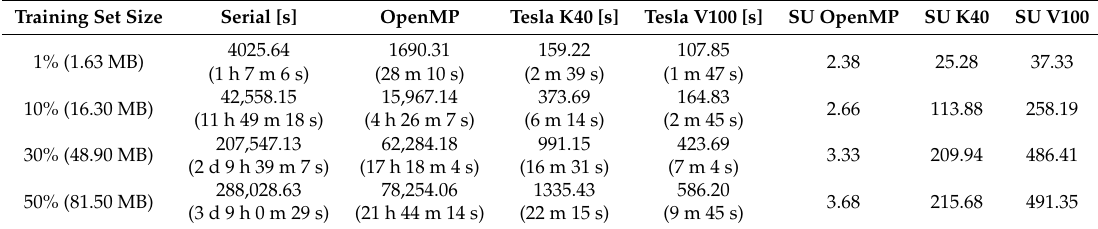
Figure 6. The classification of PaviaC image considering as training 1% ( A ), the 10% ( B ), the 30% ( C ) and the 50% ( D ) of the pixels in the image. Table 1. Processing times for the PaviaU image. The speed-up is indicated with the abbreviation SU. Training Set